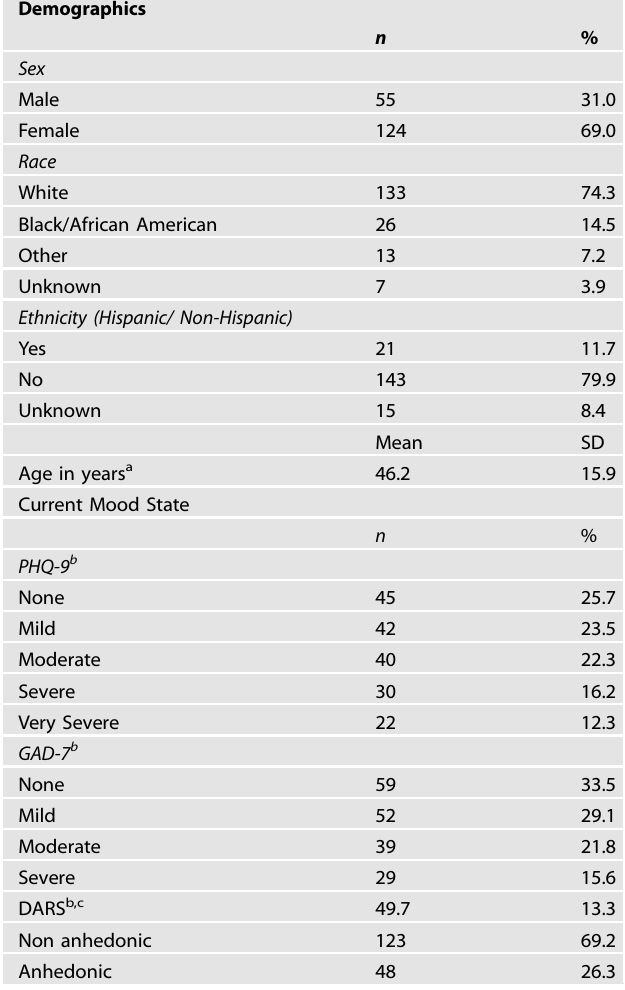
Table 1. Demographic and current mood state characteristics of the